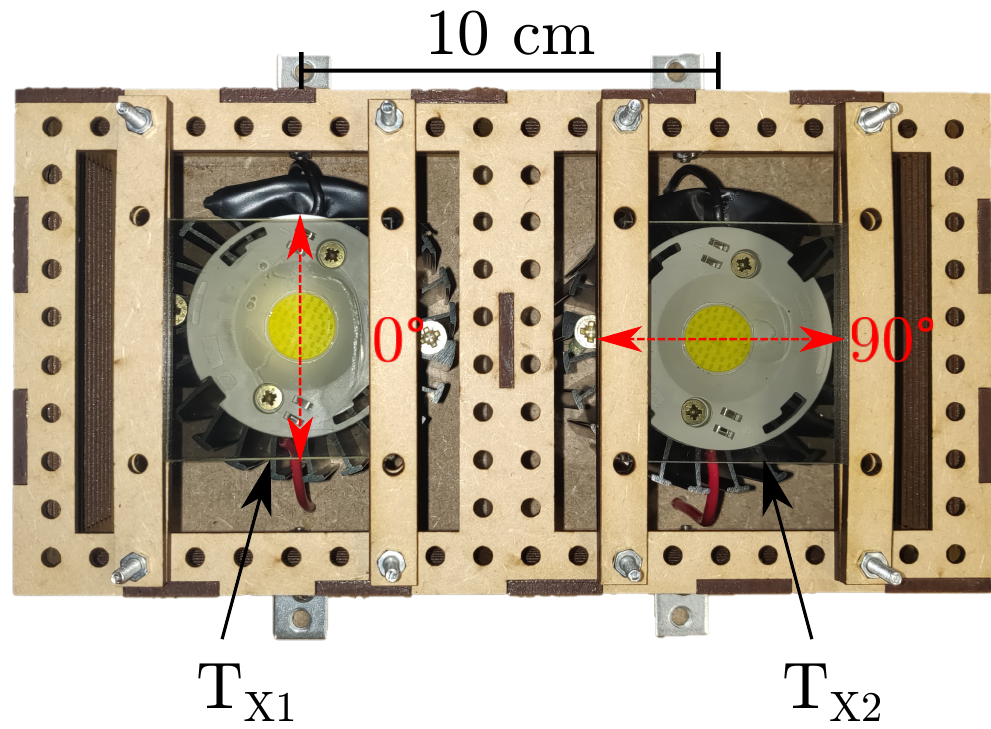
Figure 4. The two LED transmitters equipped with mutually orthogonal polarizers at 0 ◦ and 90 ◦ respectively